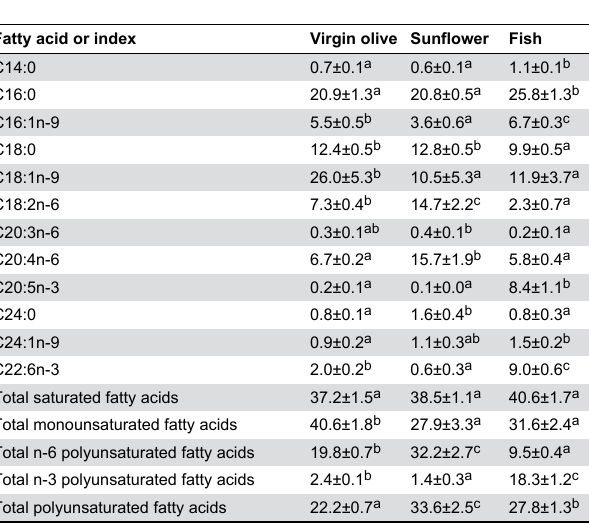
Results show means ± EEM. Lower-case letters, when different, represent